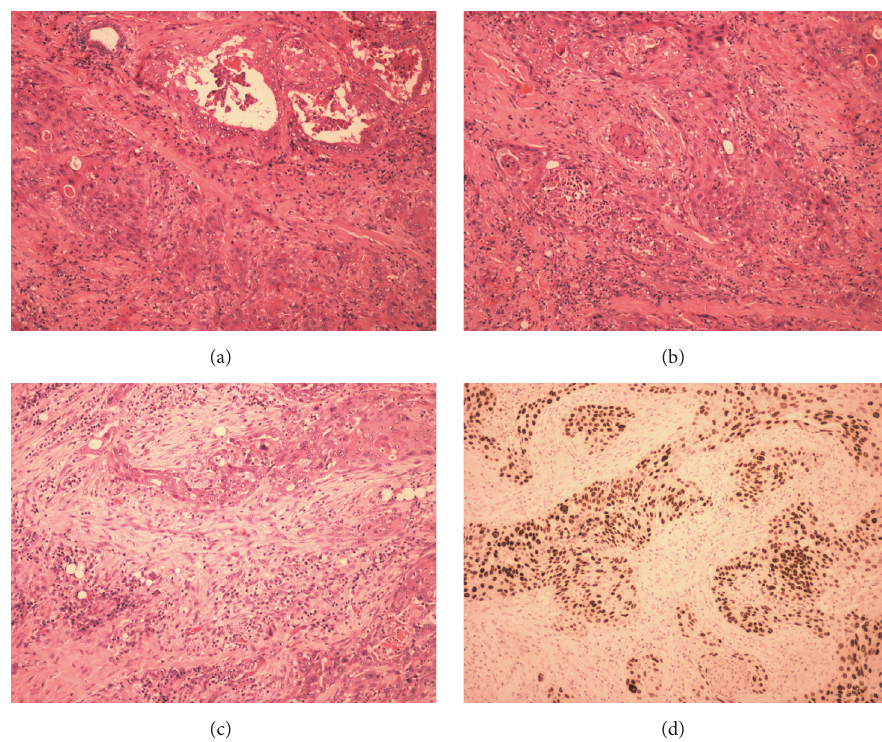
Figure 4: Histology of the tumour. (a) Features of papillary carcinoma including papillary architecture (with tall, well-formed papillae) and tumour cells that were columnar in shape, with nuclei showing overlapping, clearing, and pseudoinclusions. (b) Moderately to poorly differentiated squamous cell carcinoma. (c) Moderately to poorly differentiated squamous cell carcinoma with spindle cell elements. (d) Positive for (nuclear) thyroid transcription factor-1 (TTF-1) and Galectin-3 (cytoplasmic) in both components.